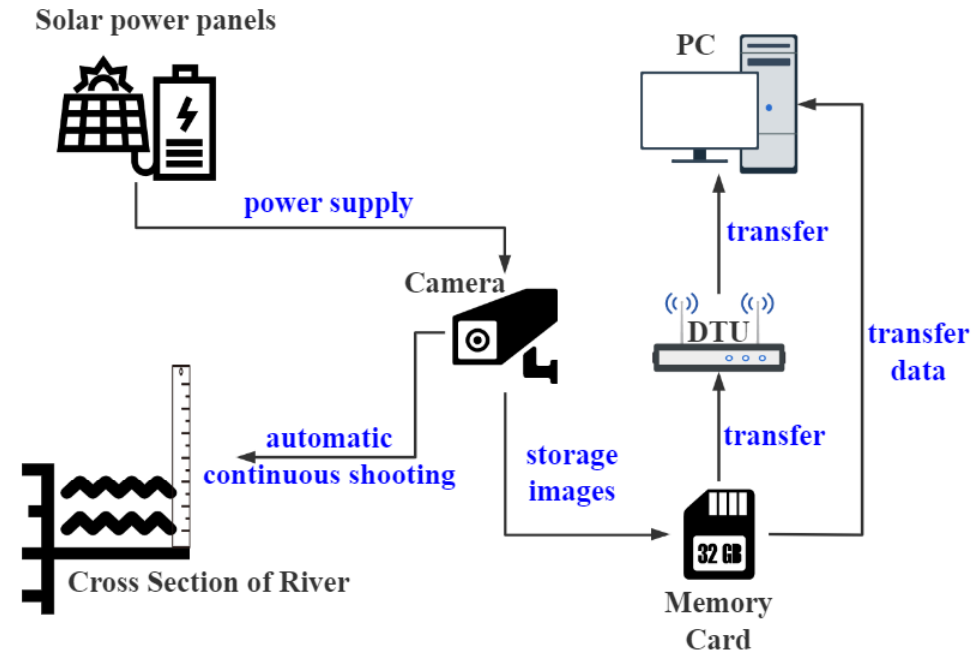
Figure 4. System schematic diagram for the water level image in the Hulu watershed.